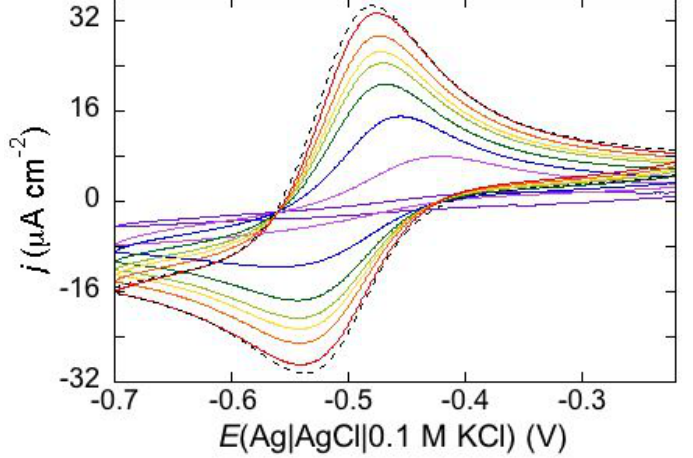
Figure 16. Cyclic voltammograms of 1.4 × 10 − 4 M Tl + in aqueous 0.1 M KCl, recorded on a mercury supported DOPC SAM at different times t measured from the addition of 0.2 μ M D1. In the order of increasing current, t equals 0, 8, 18, 28, 38, 48, 59, 75 min. The